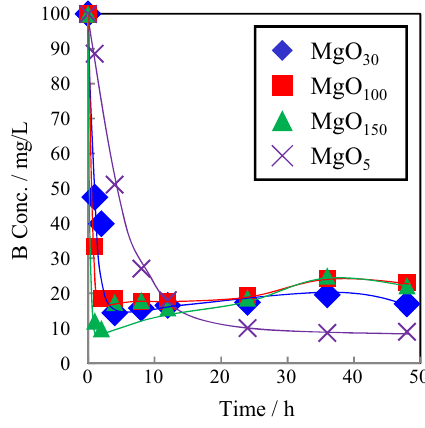
Fig. 1 Effect of specific surface area on the boron removal